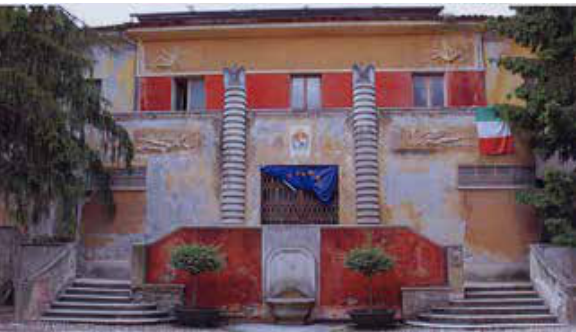
Figure 16. Digital reconstruction of the 'Teatro civico di Susa' main façade. Modeling and rendering by F. Calarco.